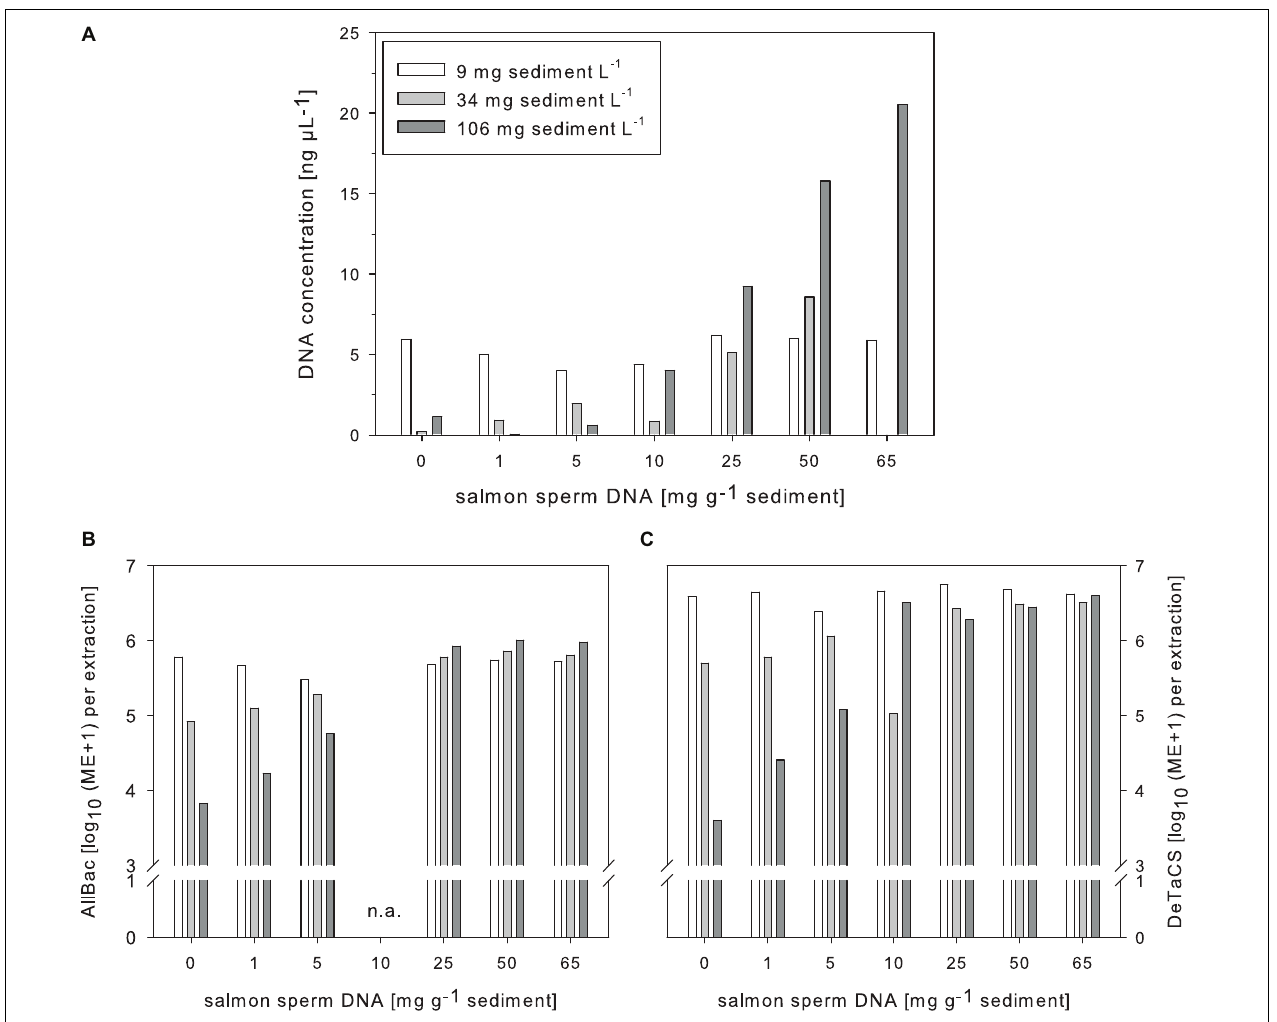
FIGURE 4 | Effects of salmon sperm DNA supplementation during DNA extraction on the DNA yield (A) , the AllBac marker concentration (B) , and the DeTaCS marker concentrations (C) of sediment-enriched samples. ME, Marker equivalents, n =